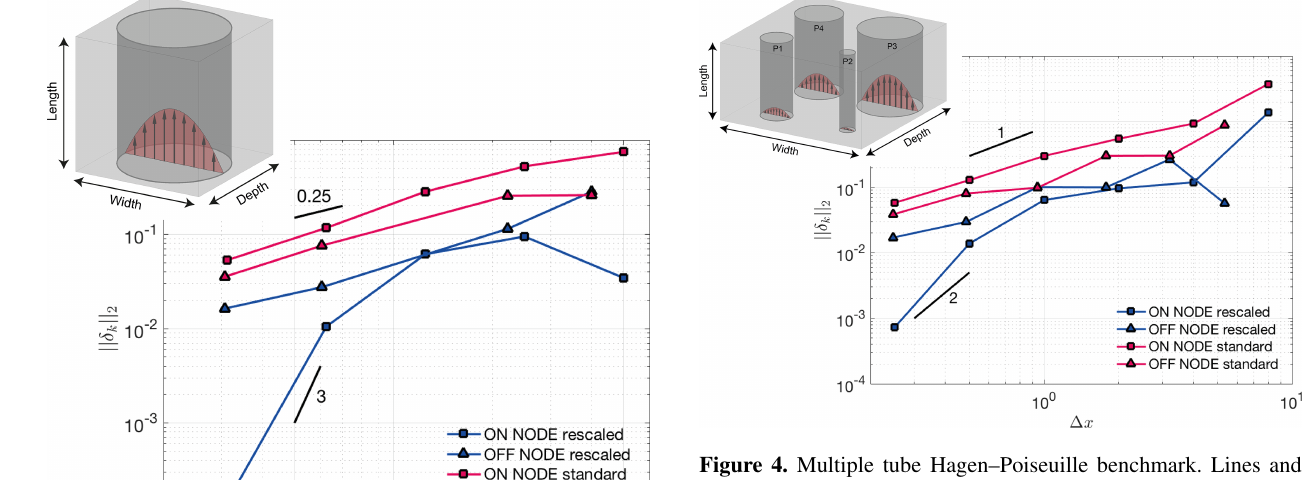
Figure 4. Multiple tube Hagen–Poiseuille benchmark. Lines and symbols correspond to the same cases as in Fig. 3. To highlight convergence, black lines with given slopes were